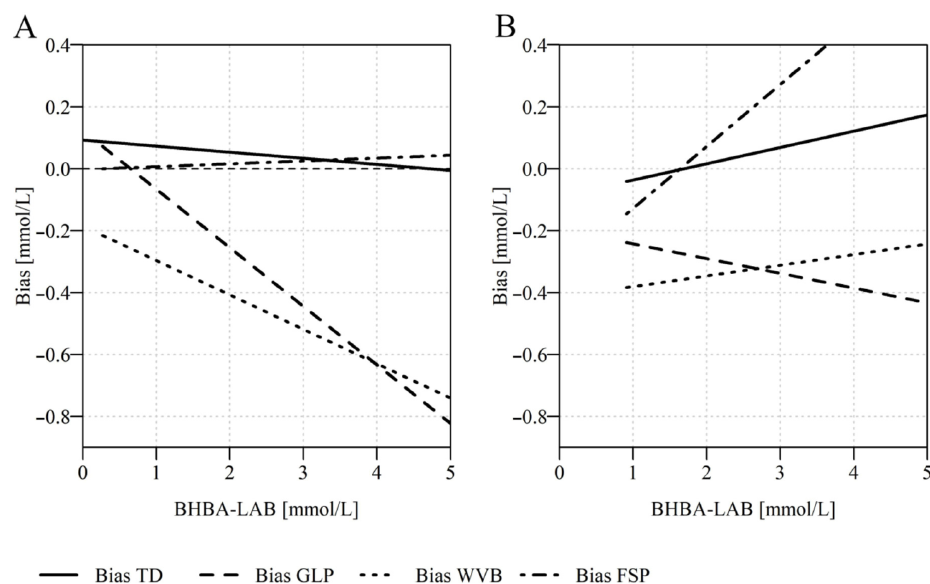
Figure 3. Absolute bias from Passing–Bablok regression for four handheld devices 2 plotted against the BHB LAB for classes total 1 ( A ) and high 1 ( B ). 1 Total: BHBA LAB unclassified; high: BHBA LAB